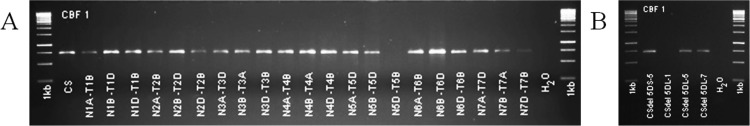
Example of fragment localisation from Cbf1 via NT- and deletion-lines.(A) The missing PCR fragment on NT-line N5D-T5B indicated the location on wheat chromosome 5D. (B) The missing PCR fragment on Csdel 5DL-1 indicated the location on wheat long arm of chromosome 5D between the deletion segments 1 and 5.